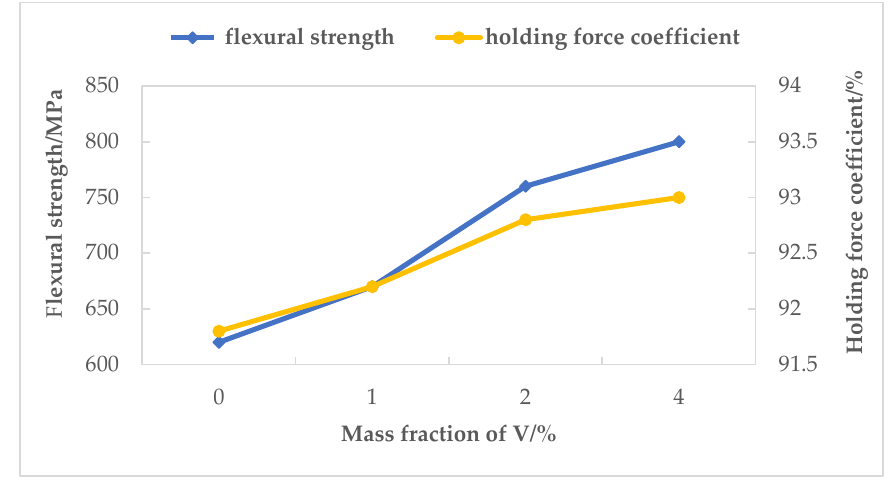
Figure 3. Effects of mass fraction of V on the flexural strength and the holding force.